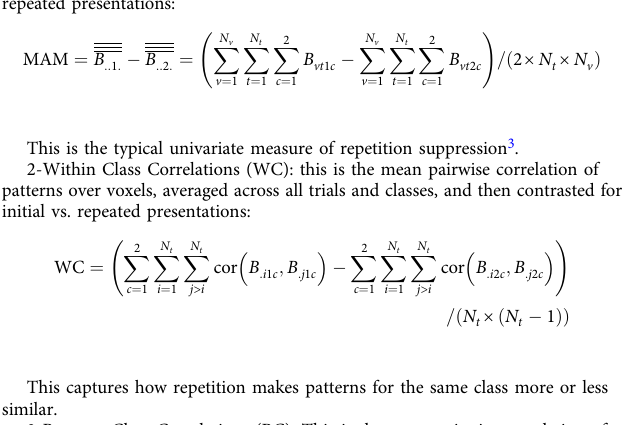
tions) for each stimulus class and presentation ( Nt ) corresponded to 49 events in Experiment 1, and the 8 sub-runs in Experiment 2. We identi fi ed 6 properties of the fMRI data, based on various analyses that have been reported in various fMRI studies 14,15 , though never investigated simultaneously within a single study: 1-Mean Amplitude Modulation (MAM): this represents the mean, over voxels, trials and the two classes, of the difference in the fMRI response to the initial vs. repeated